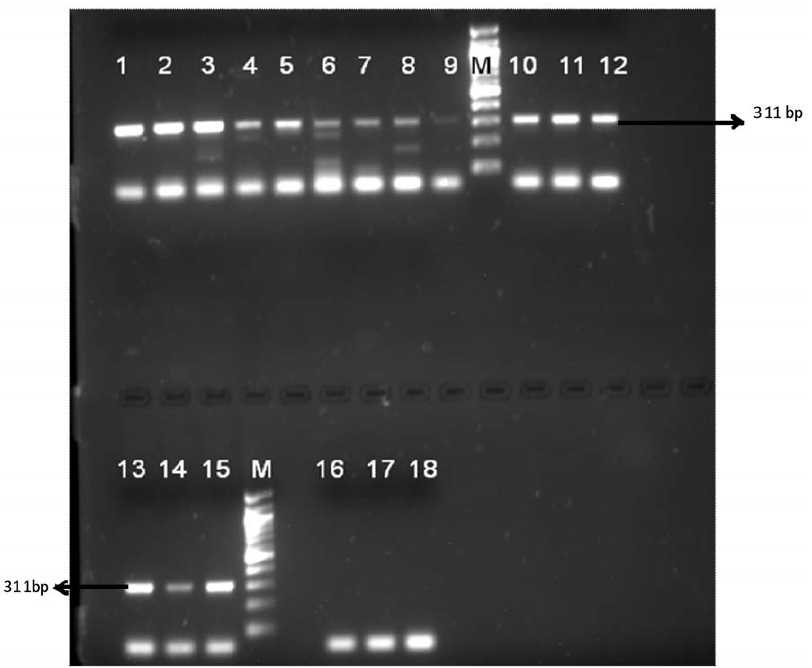
Figure 2. PCR result for spiked samples. Lane 1–3: 10,000 parasites, Lane 4–6: 1000 parasites, Lane 7–9: 100 parasites, Lane 10–12: 10 parasites, Lane 13–15: 1 parasite, Lane 16–18: No Template controls (NTC), M=100 bp marker.